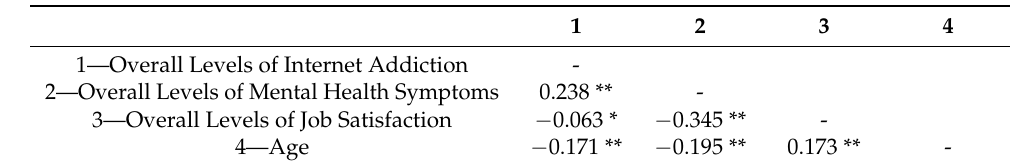
Table 4. Correlation